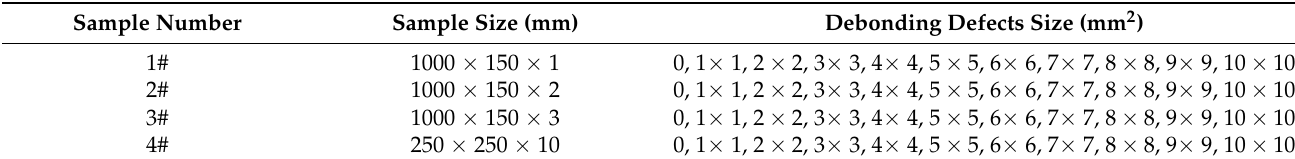
Table 2. Technical specifications of simulated debonding defects test samples.